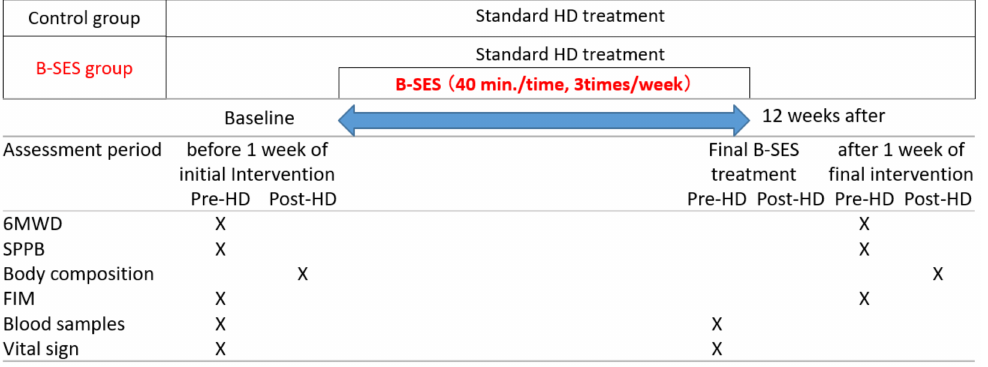
Figure 1. Schematic diagram of study schedule. Most variables were assessed pre-hemodialysis, while body composition was assessed post-hemodialysis. “Vital sign” included assessment of systolic and diastolic blood pressure. 6MWD, 6-Minute Walk Distance; SPPB, Short Physical Performance Battery; and FIM, Functional Independence